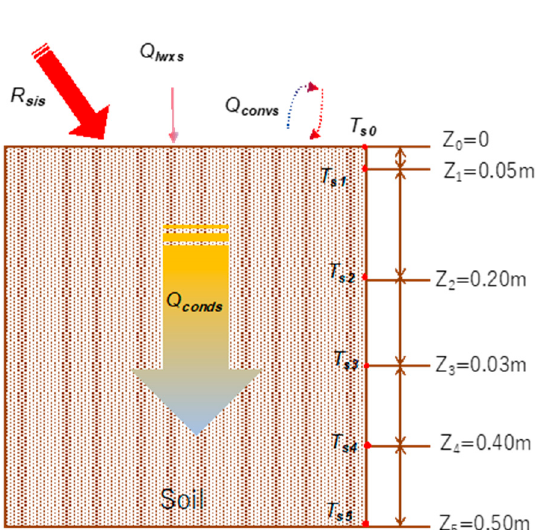
Figure 9. Heat transfers in the greenhouse soil.